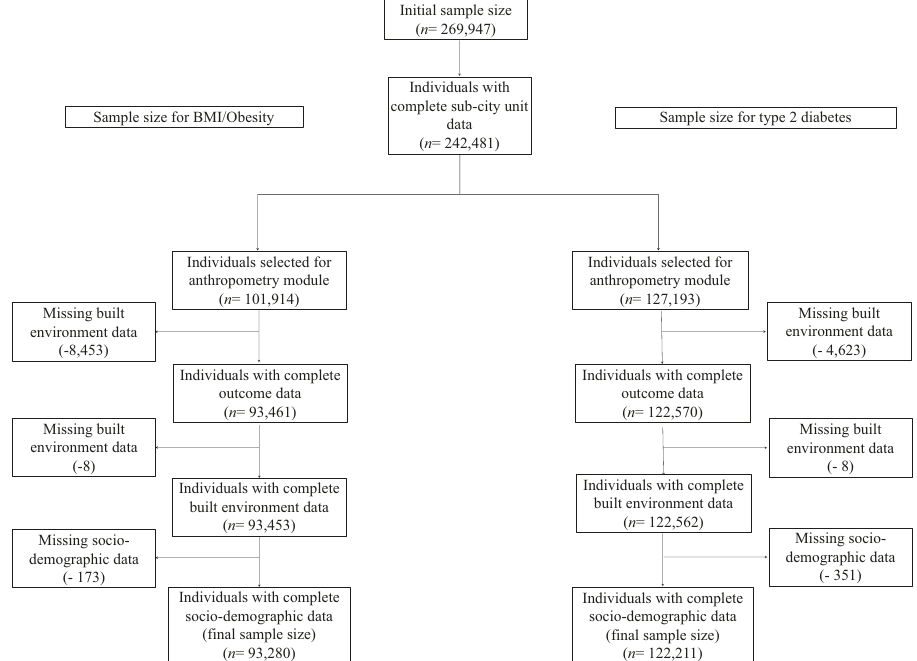
Fig. 1 | Flowchart. Flowchart describing the sample size and those with complete data analyzed for each of the